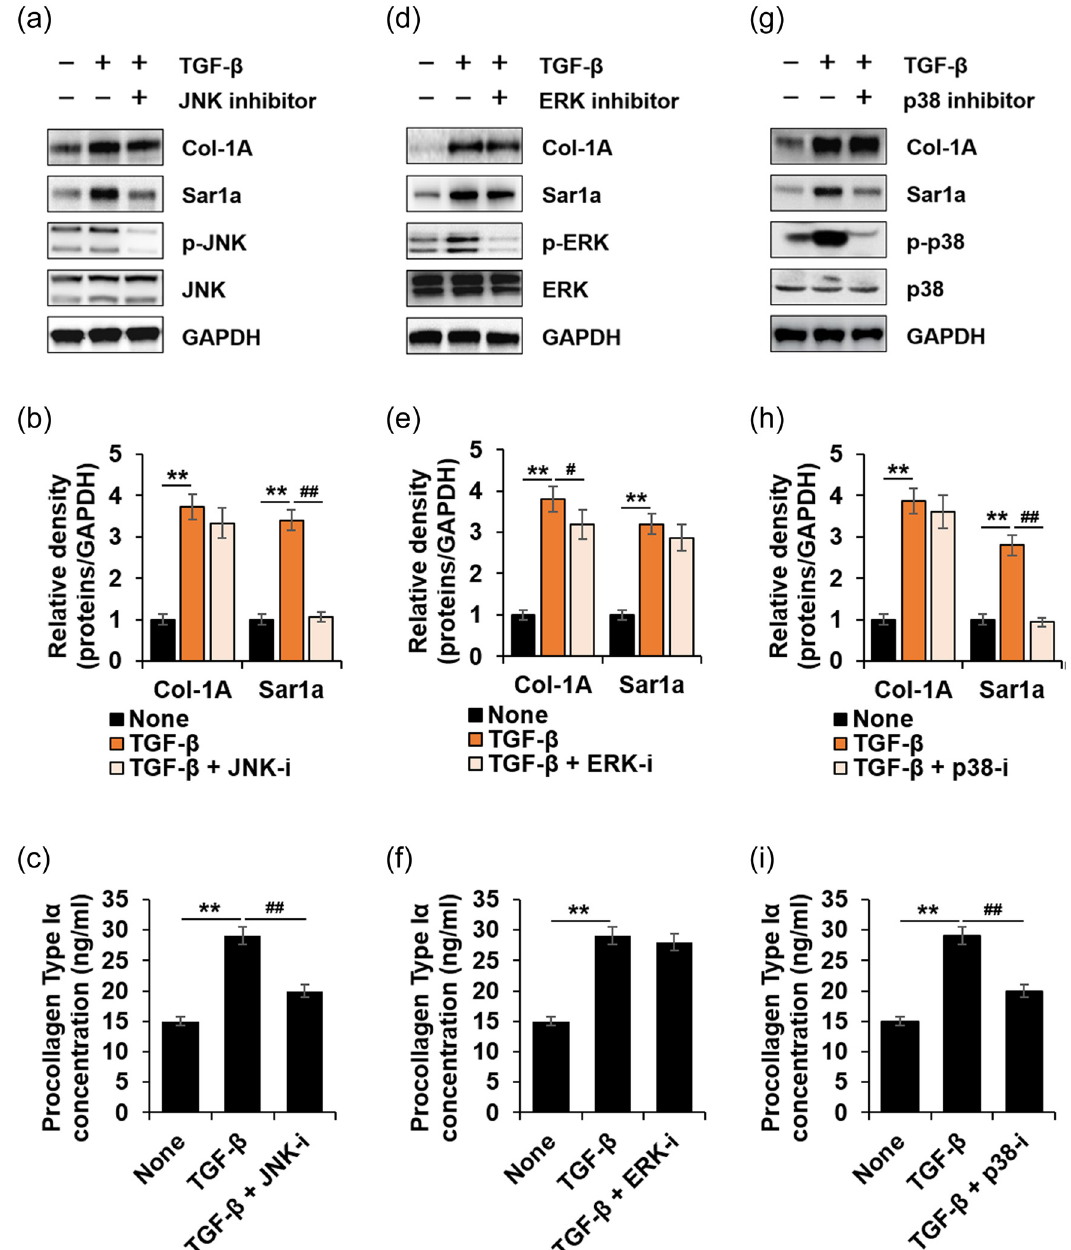
Figure 4: JNK and p38 are involved in TGF - β 1 - induced Sar1a expression. HTSF were cultured in 6 - well plates, serum - starved for 16 h, and then treated with or without 10 ng/mL TGF - β 1, TGF - β 1 + 10 μ M JNK inhibitor ( SP600125 ) , 50 μ M ERK inhibitor ( PD98059 ) , or TGF - β 1 + 10 μ M p38 inhibitor ( SB203580 ) for 24 h. The cell culture supernatant was collected for PC - I ELISA ( c, f, and i ) , and cell lysates were immunoblotted with antibodies against the indicated proteins ( a, d, and g ) . ( a ) Immunoblots of Col - 1A, Sar1a, phosphor - JNK, JNK, and GAPDH as the loading control. ( b ) Fold change of Col - 1A or Sar1a was calculated ( n = 3, ± SD ) . None vs TGF - β 1; ** p < 0.01. TGF - β 1 vs TGF - β 1 + JNK - i; ## p < 0.01. ( c ) Secreted PC - I was determined via ELISA ( n = 3, ± SD ) . None vs TGF - β 1; ** p < 0.01. TGF - β 1 vs TGF - β 1 + JNK - i; ## p < 0.01. ( d ) Immunoblots of Col - 1A, Sar1a, phosphor - ERK, ERK, and GAPDH as the loading control. ( e ) Fold change of Col - 1A or Sar1a was calculated ( n = 3, ± SD ) . None vs TGF - β 1; ** p < 0.01. TGF - β 1 vs TGF - β 1 + ERK - I; # p < 0.05. ( f ) Secreted PC - I was determined via ELISA ( n = 3, ± SD ) . None vs TGF - β 1; ** p < 0.01. ( g ) Immunoblots of Col - 1A, Sar1a, phosphor - p38, p38, and GAPDH as the loading control. ( h ) Fold change of Col - 1A or Sar1a was calculated ( n = 3, ± SD ) . None vs TGF - β 1; ** p < 0.01. TGF - β 1 vs TGF - β 1 + p38 - I; ## p < 0.01. ( i ) Secreted PC - I was determined via ELISA ( n = 3, ± SD ) . None vs TGF - β 1; ** p < 0.01. TGF - β 1 vs TGF - β 1 + p38 - i; ## p <